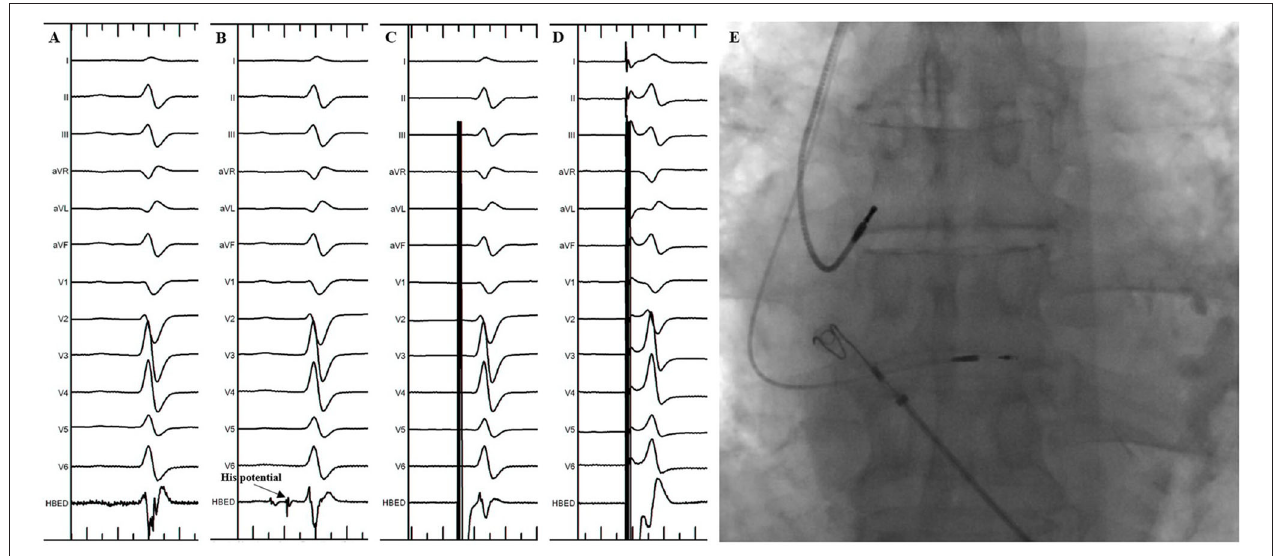
FIGURE 1 | His Bundle Pacing implantation in the standard group. (A) Sinus rhythm before the procedure. (B) His potential was recorded during the procedure. (C) Selective His bundle pacing was confirmed at a lower pacing output. (D) Nonselective His bundle pacing was achieved at a higher pacing output. (E) Final lead location in the fluoroscopic image.